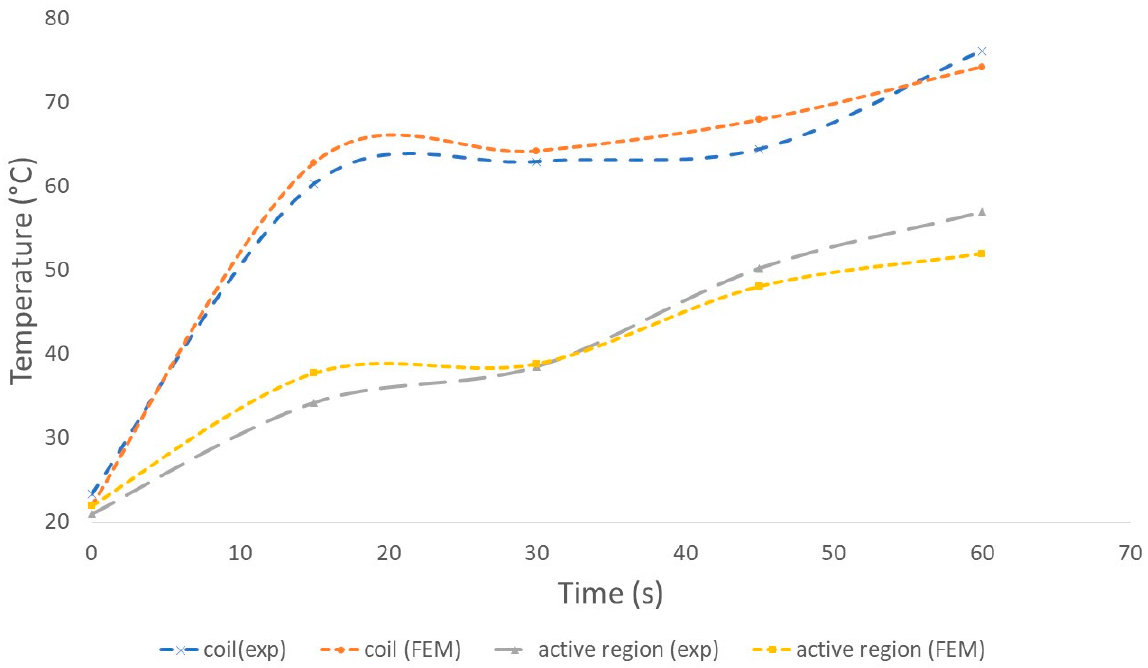
Figure 5. Heat generation process on braking in active region and coil.